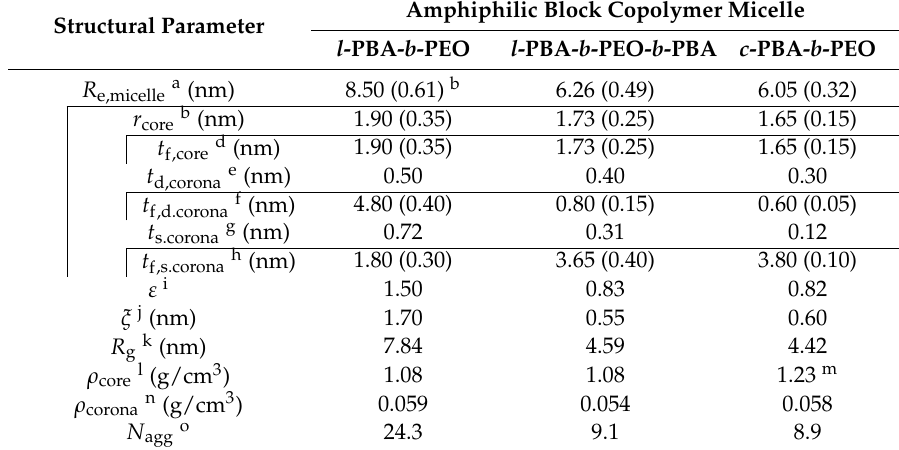
Table 5. Structural parameters of micelles of the amphiphilic block copolymers obtained from the quantitative analysis of scattering data with three phase ellipsoid